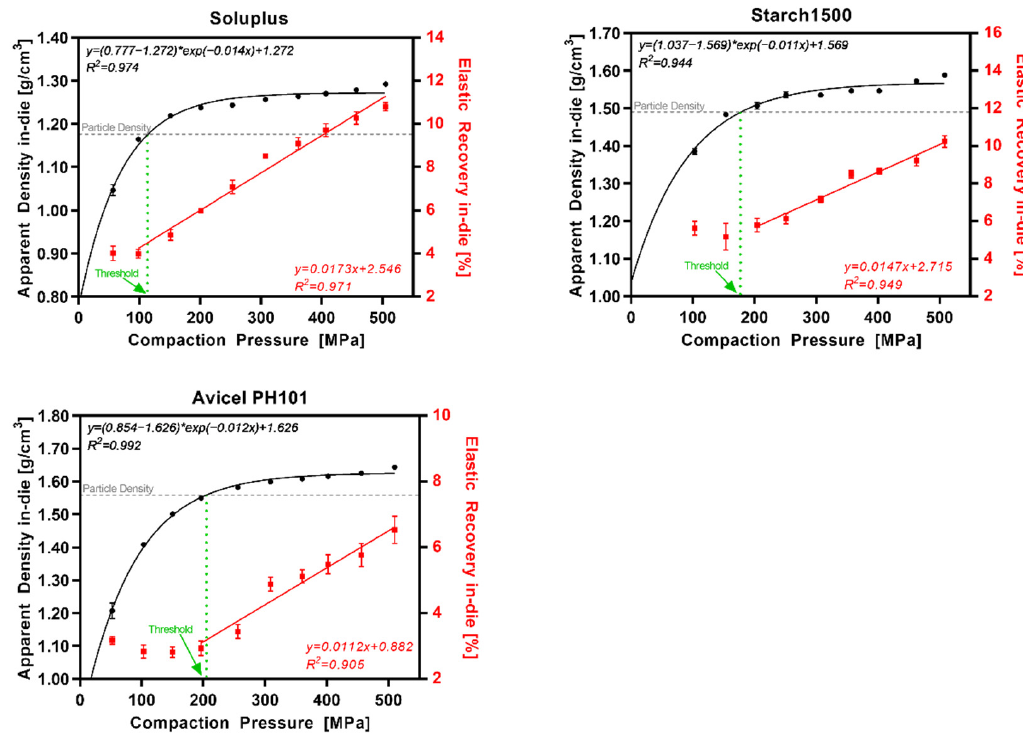
Figure 5. Polymeric excipients: apparent density in-die (black) and elastic recovery in-die (red) at different compaction pressures; particle density (grey dotted line); threshold in CP where ρ app = ρ par (green dotted line).